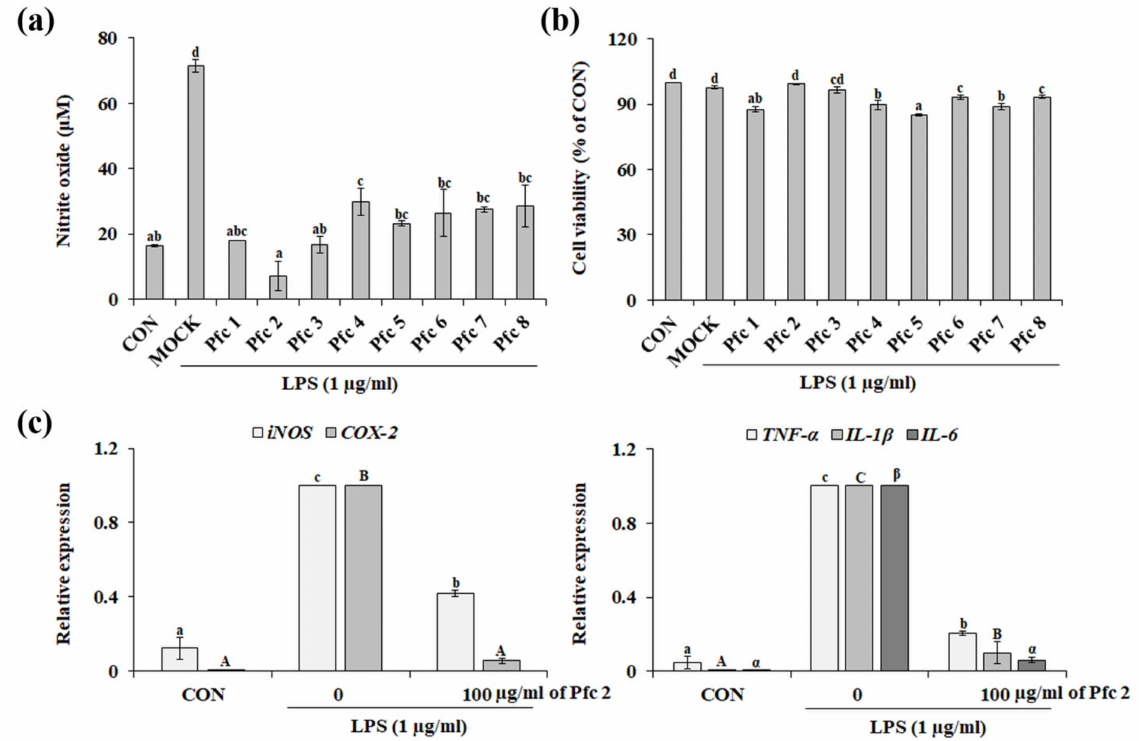
Figure 3. Comparison of anti-inflammatory activities among Perilla frutescens var. crispa (Pfc) genotypes. Effects of Pfc genotype on NO production ( a ) and cell viability ( b ) in LPS-treated RAW 264.7 cells. ( c ) Effect of Pfc 2 on the expression of LPS-induced iNOS , COX-2 , TNF- α , IL-1 β , and IL-6 in RAW 264.7 cells. The expression levels for each gene were calculated relative to its expression in LPS-stimulated RAW 264.7 cells (0 µ g/mL of Pfc 2). The mean of three independent experiments is plotted with SE. Different letters indicate significant differences among the groups ( p <